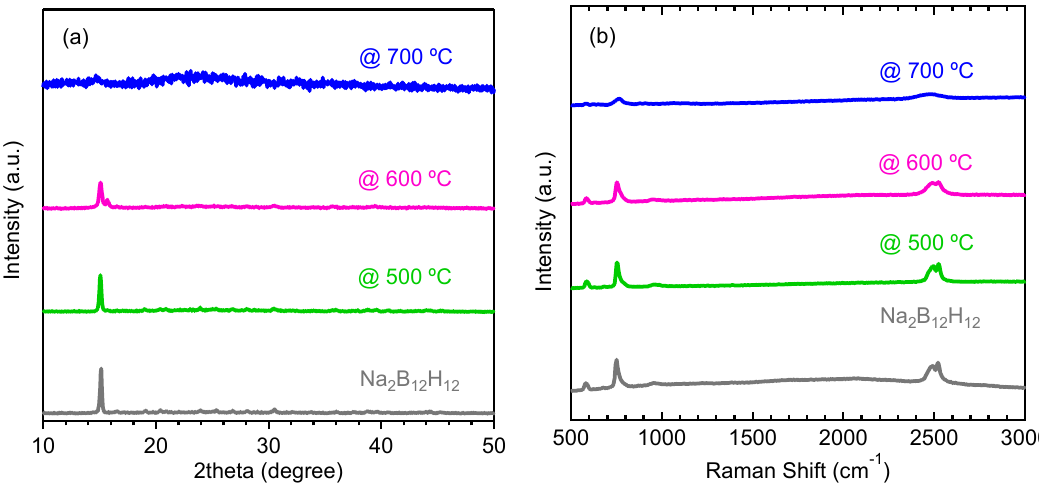
Figure 6. Ex-situ 11 B NMR spectra of anhydrous Na 2 B 12 H 12 as synthesized and heated up to respective temperatures: ( a ) solid-state 11 B MAS NMR spectra and ( b ) solution-state 11 B NMR spectra measured in DMSO-d 6 . Resonance assignments: − 15.6 ppm [B 12 H 12 ] 2 − , − 35.9 ppm [BH 4 ] − , − 28.8 ppm [B 10 H 10 ] 2 − [32].